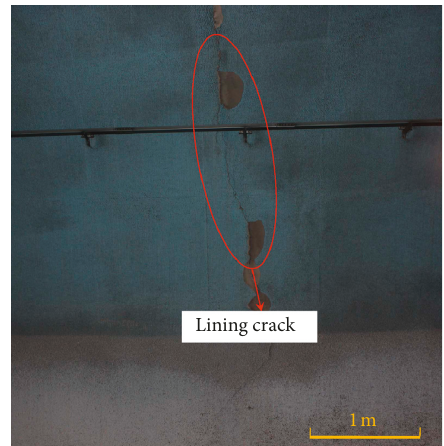
Figure 18: Photograph of the lining crack at